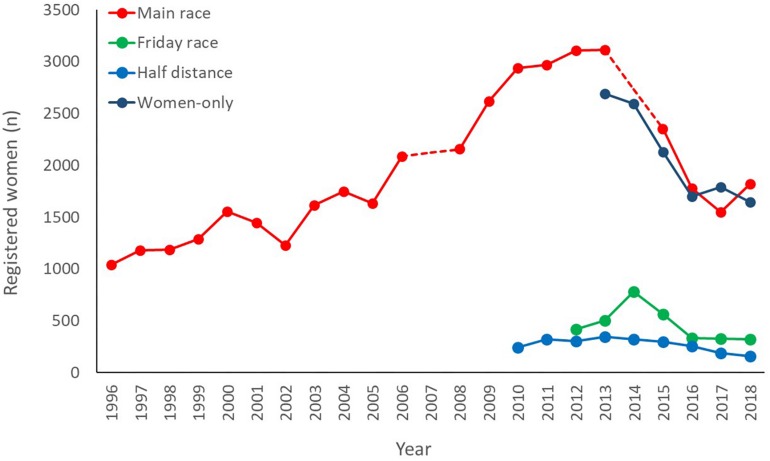
Entries for women (n), expressed as registered participants, in the main ski race and other races (Friday, half-distance, and women-only). The main race was canceled in 2007 and 2014, as marked by a discontinuous line. The women-only race came under the organization of Birken AS in 2013, thought it has been taking place since 1993 (entry records before 2014 are not available).